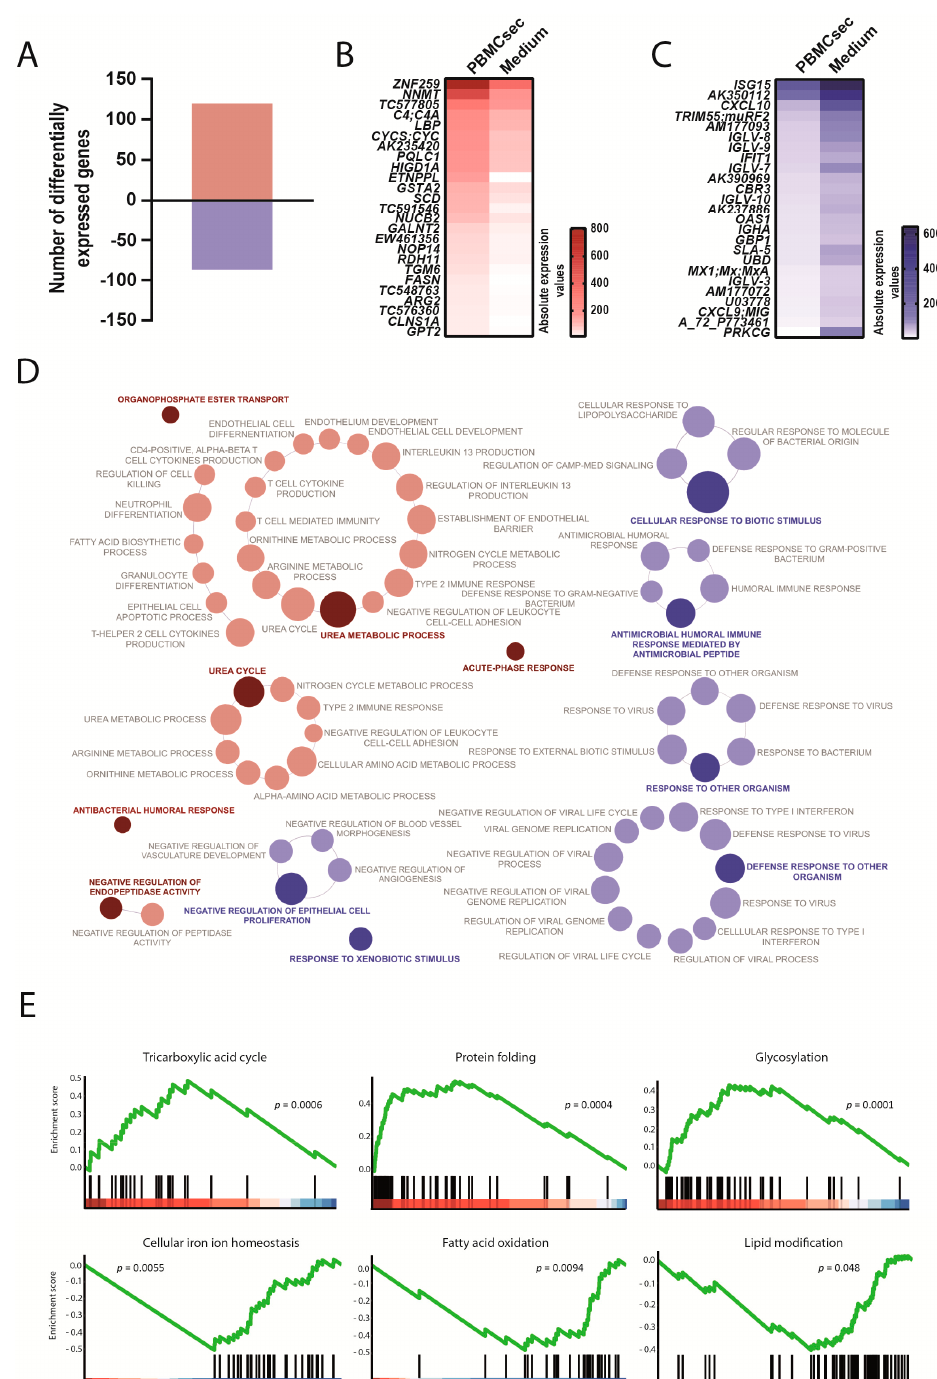
Figure 6. Transcriptional changes induced by the PBMCsec in the liver. ( A ) Total numbers of differentially expressed genes. Red and blue indicate up- and downregulated genes, respectively, when comparing the PBMCsec versus the medium. The average fold change of n = 6 animals per group is shown. Absolute expression values of genes ( B ) up- and ( C ) downregulated by the PBMCsec compared with the medium. Colors indicate expression values. ( D ) GO terms associated with up- (red) and downregulated (blue) genes. Each circle represents one term. Circle sizes indicate p -values. Overarching terms within a group are highlighted in bold. ( E ) GSEA of up- (upper panel and protein glycosylation in lower panel) and downregulated (two terms on lower left) genes by the